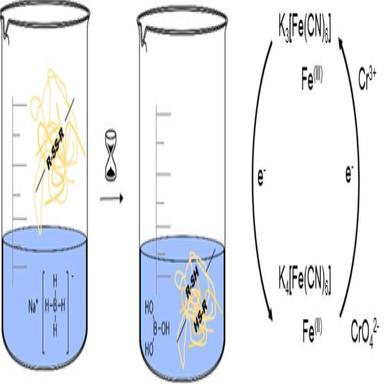
Schematic presentation of thiol determination in wool fibres by back titration.